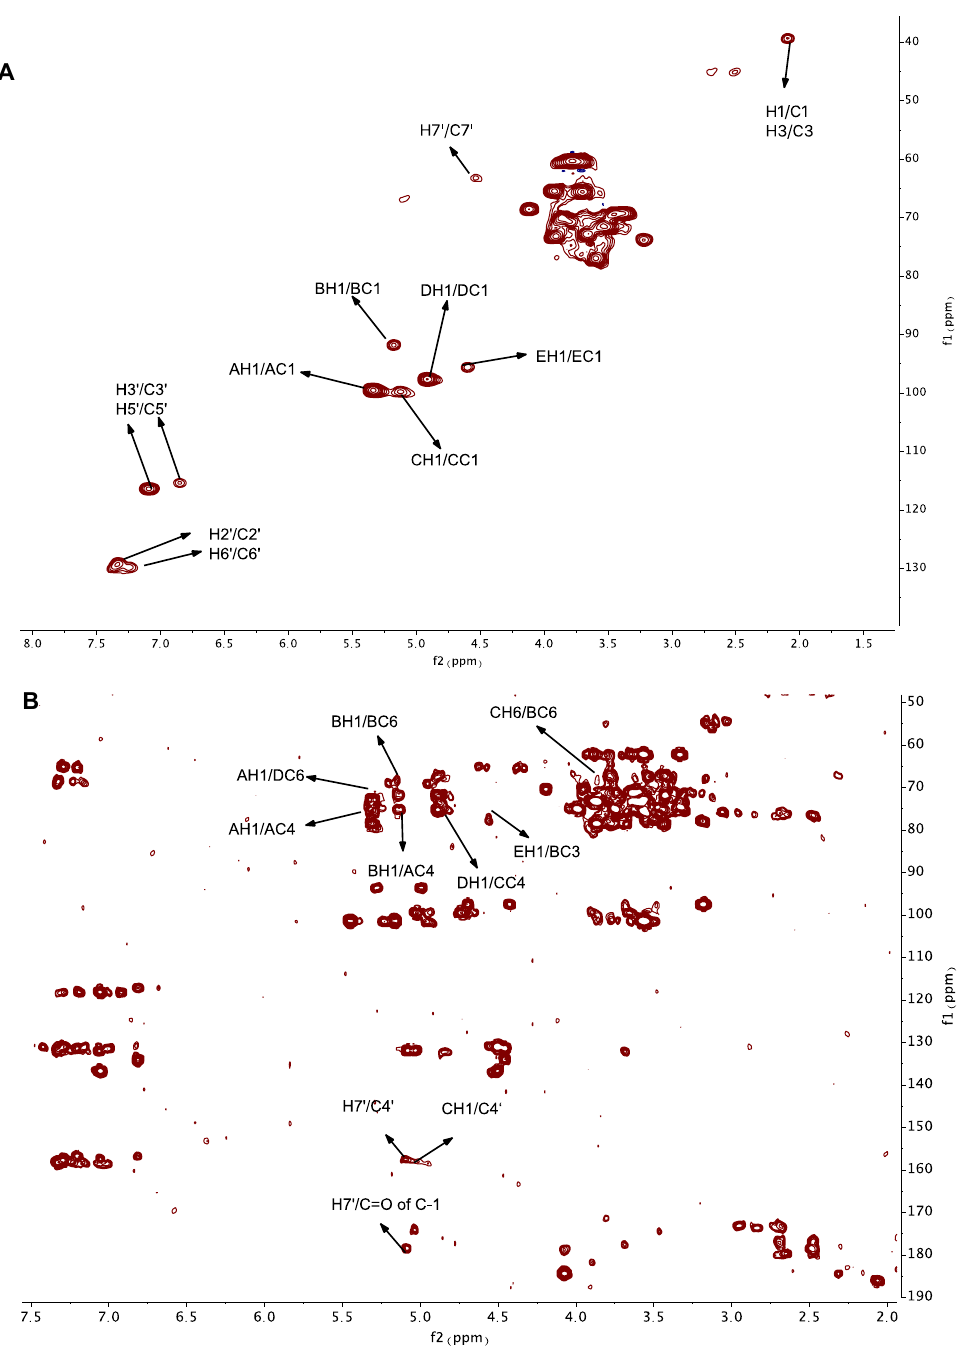
Figure 2. HSQC ( A ) and HMBC ( B ) spectra of GEP-1.